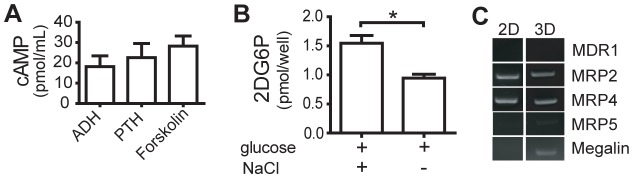
NKi-2 cells maintain kidney function when grown in 3D tissues.(A) Adenylate cyclase activity in NKi-2 cells within the bioengineered 3D tissue upon treatment with ADH or PTH. Treatment with forskolin acted as a control for production of cAMP. n  =  4. (B) Na+ dependent glucose uptake in NKi-2 cells within the bioengineered 3D tissues. Tissues were exposed to 2-DG with or without Na+ in the form of NaCl. *p<0.05, n  =  5. (C) RT-PCR of drug tranporters found in kidney epithelial cells using RNA from both NKi-2 cells and 4 week 3D tissues. (C) RT-PCR of different transport proteins found in human kidney cells in both NKi-2 cells (2D) and 4 week old 3D tissues.